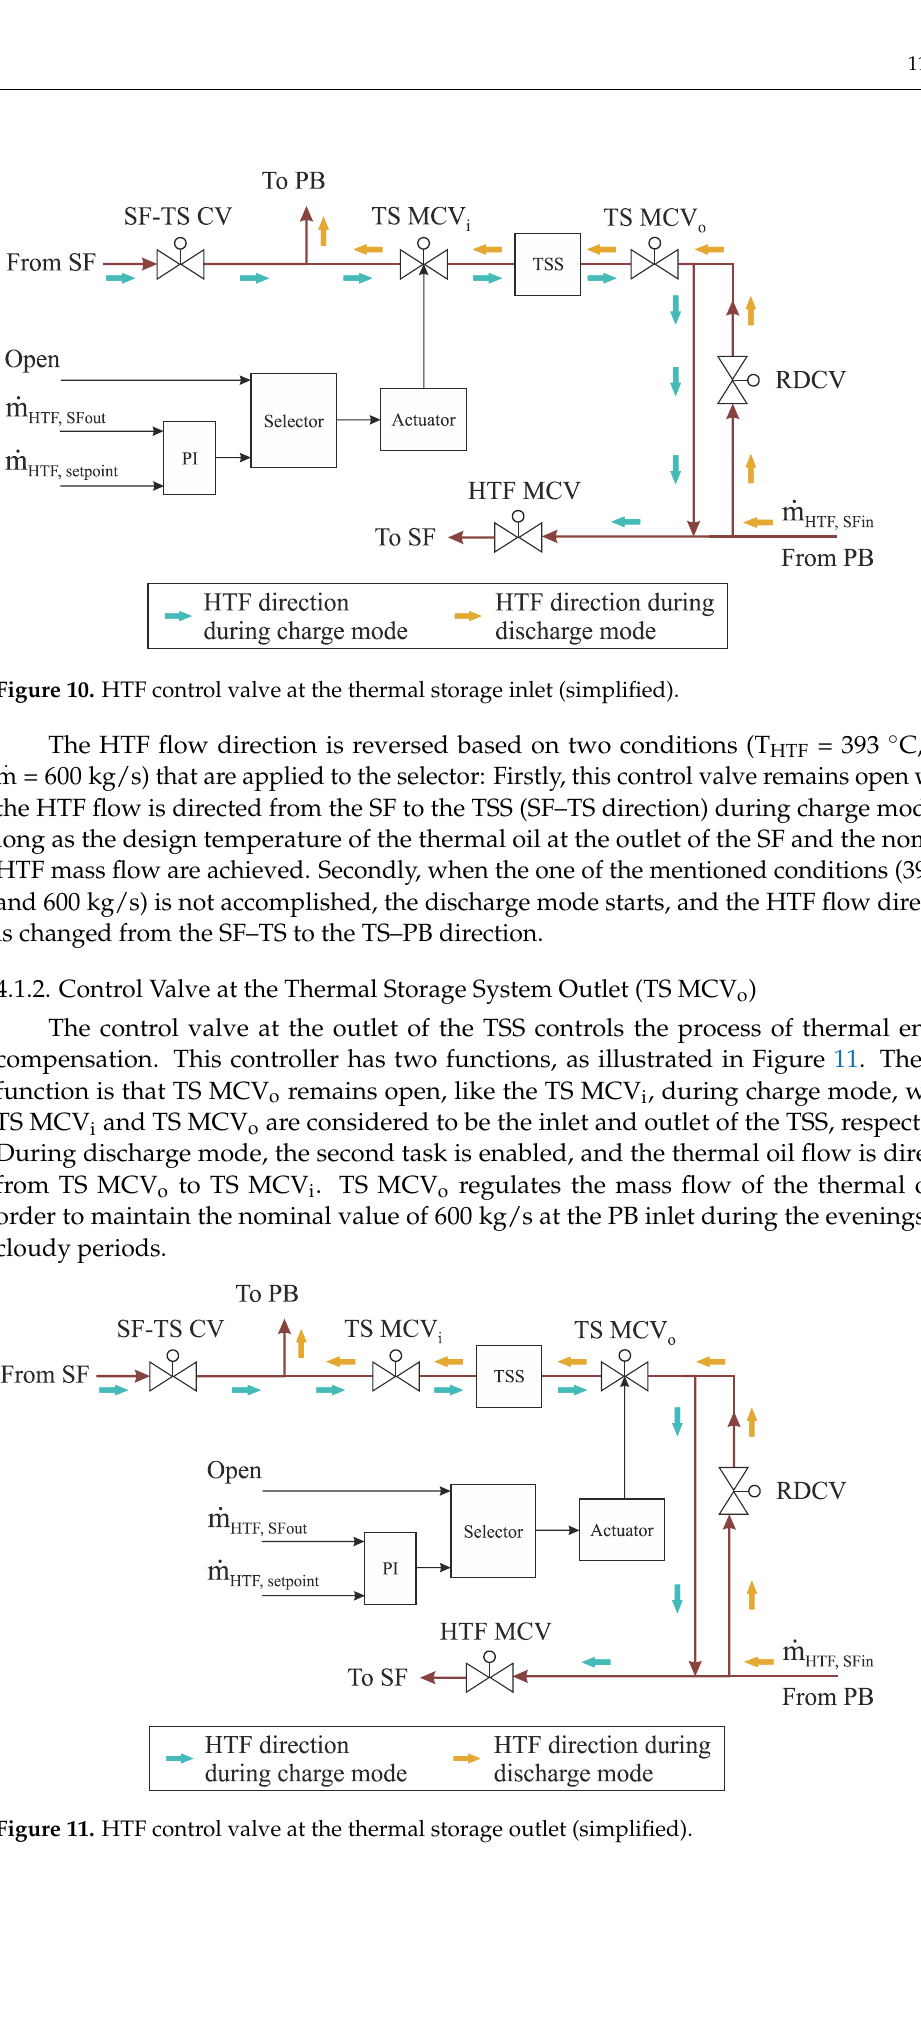
. Figure 12. Hot tank control valve (during discharge mode) (simplified).